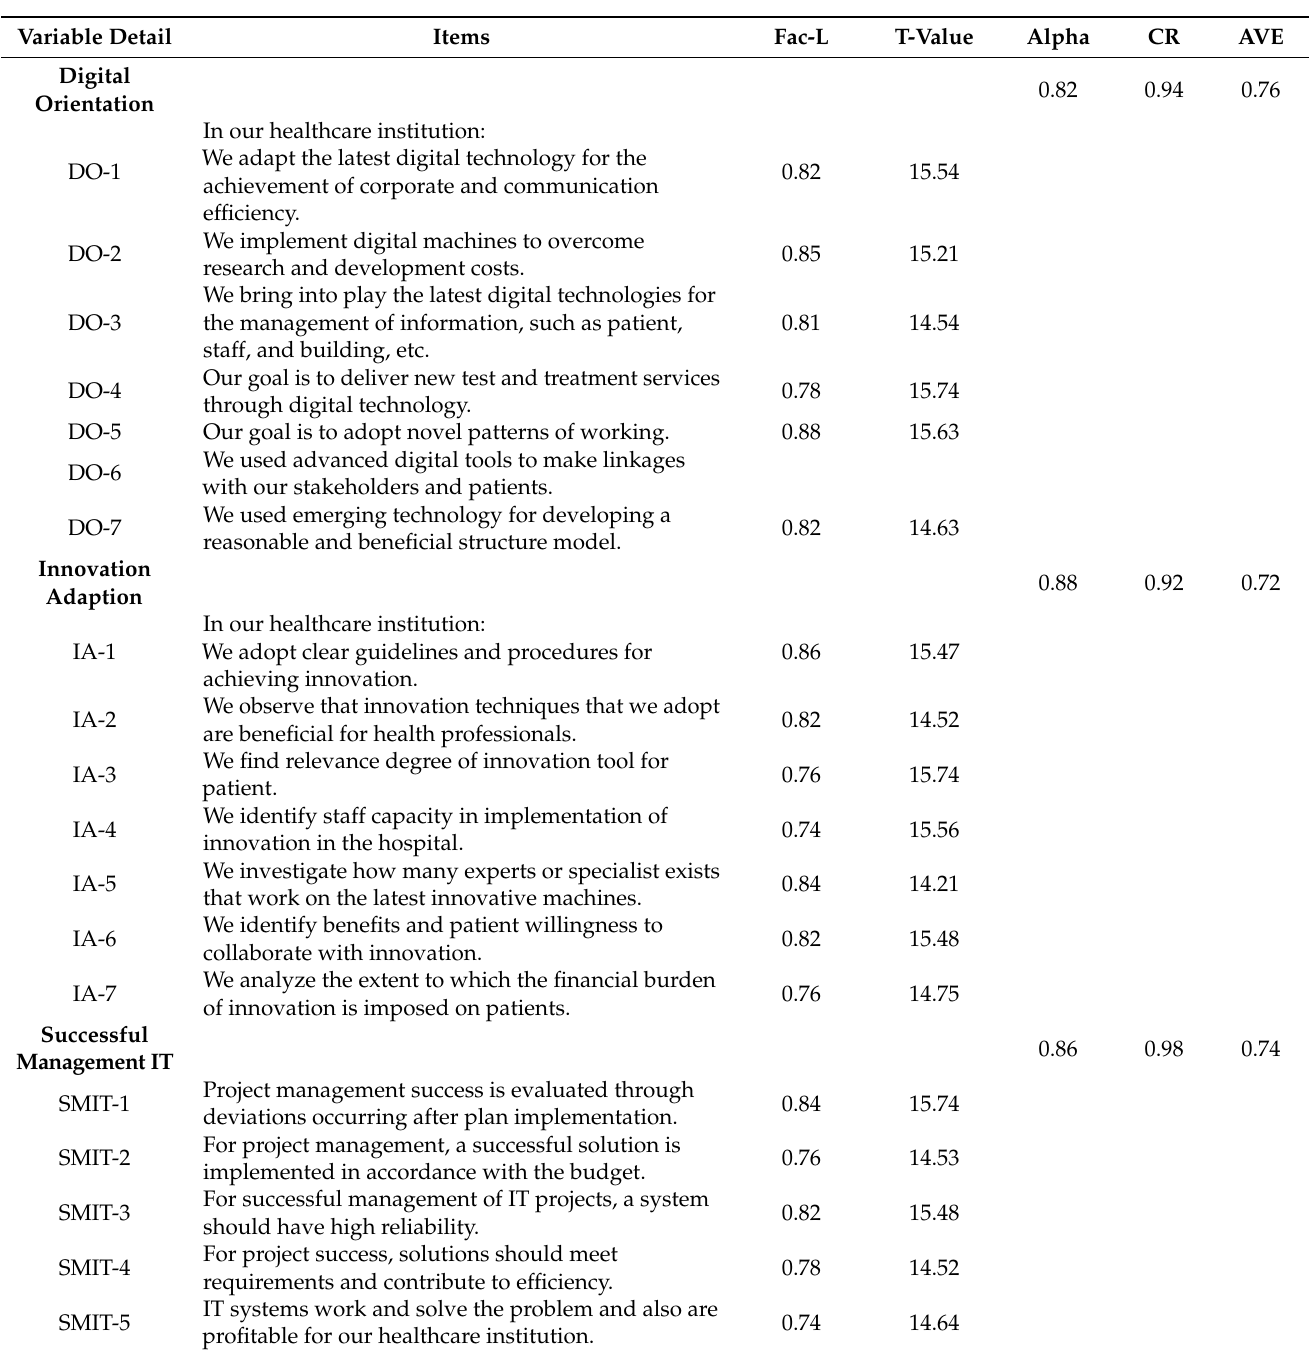
Table 1. Results of Cronbach’s alpha, CR and AVE.